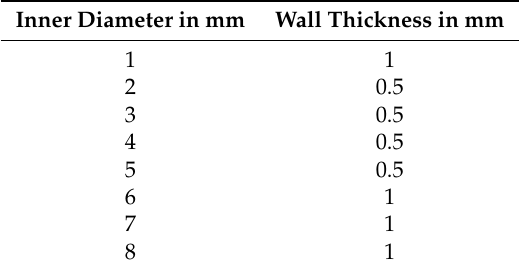
Figure 4. An exemplary image of a silicone tube filled with Indocyanine Green (ICG). It is fixed to a rotational board and the red line indicates 0° of rotation. Table 2. Tubes used in the